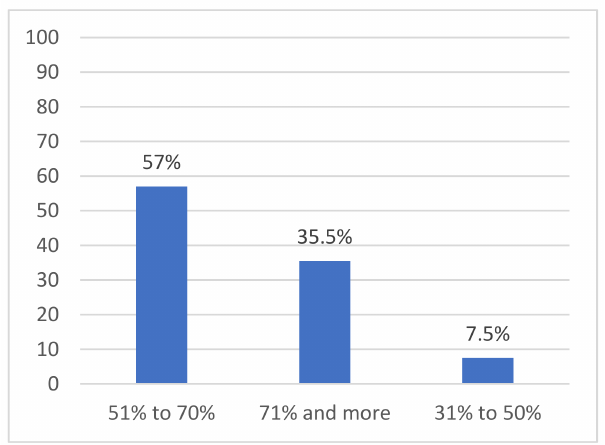
Figure 8. Increase in safety awareness rate after safety